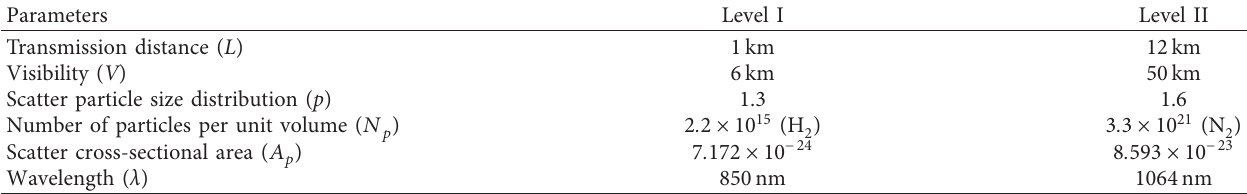
Table 7: Free space optics attenuation experiment design chart for L8.